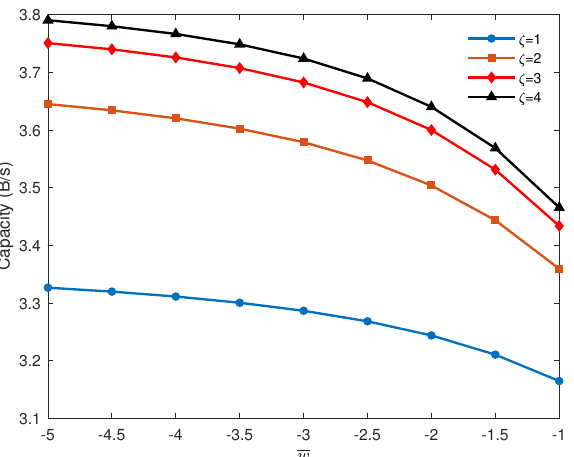
Figure 8. Information capacity of OAM channels versus dissipation rate of the mean-squared temperature χ T and dissipation rate of kinetic energy per unit mass of fluid (cid:101) .